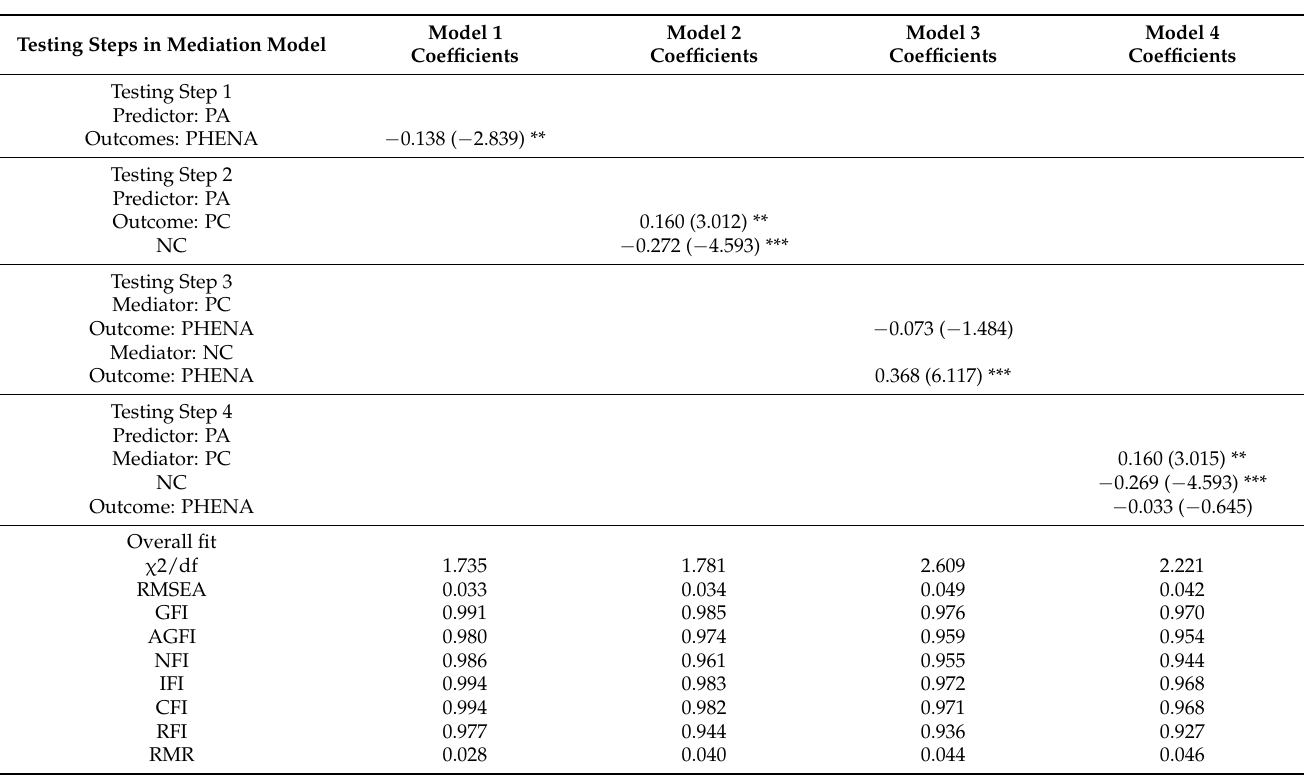
Table 2. Testing mediator effects using structural equation model.